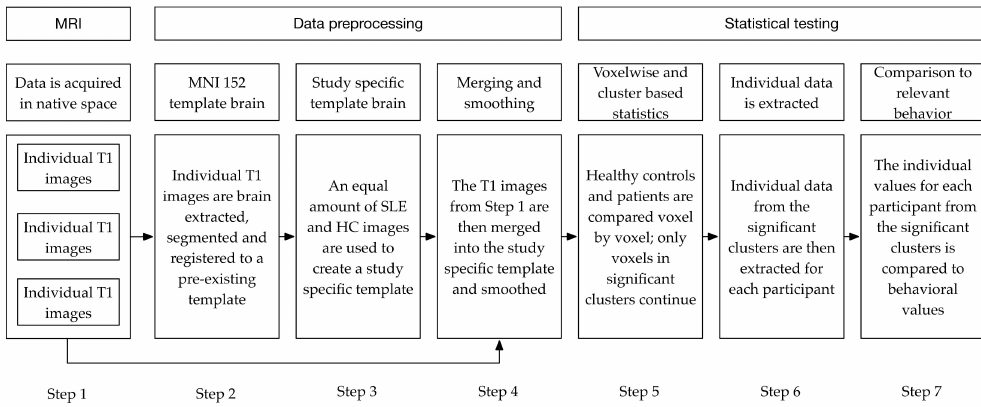
Figure 4. Schematic depicting the different data processing steps. The individual steps are described below in the sections MRI (Magnetic Resonance Imaging), Data preprocessing and Statistical